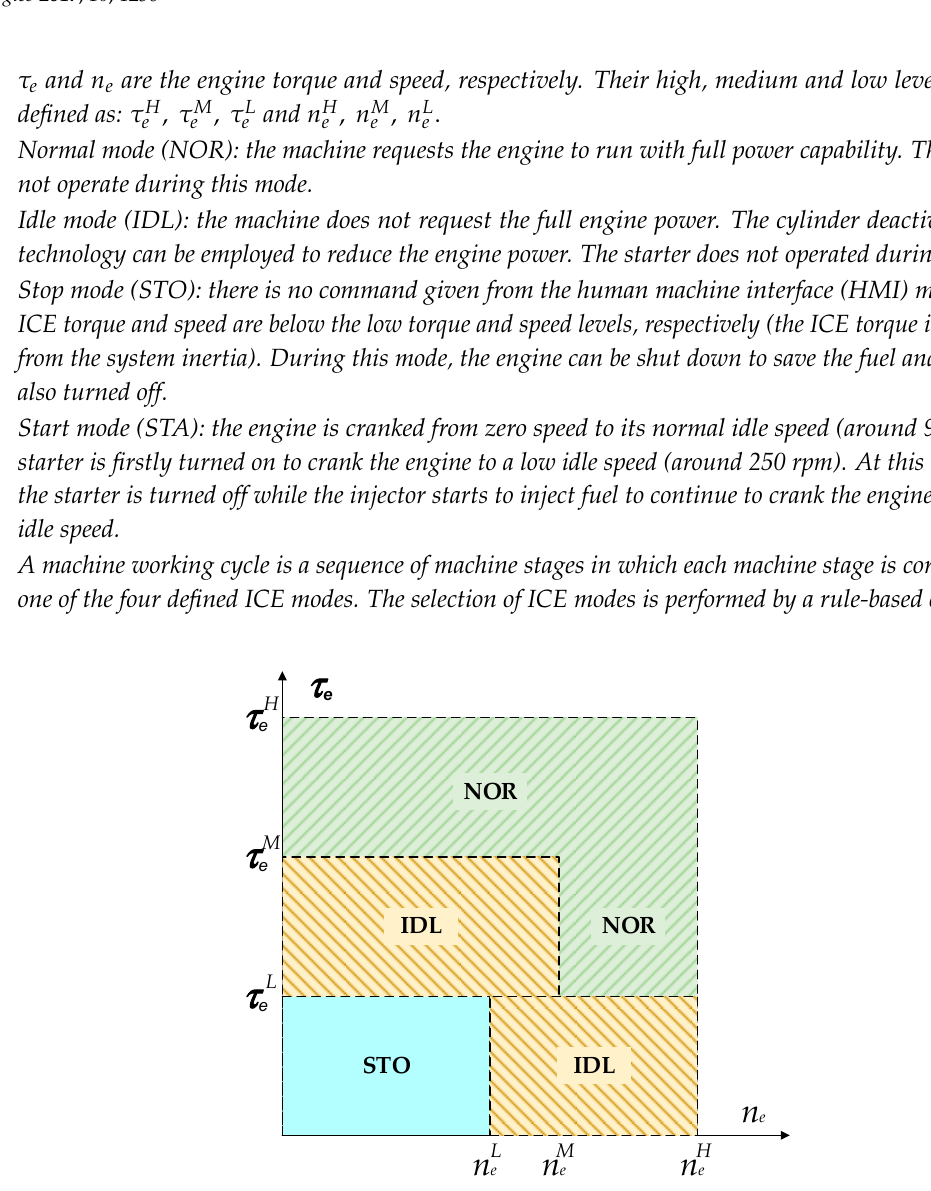
Figure 2. ICE mode definition based on ICE torque-speed bands [12].